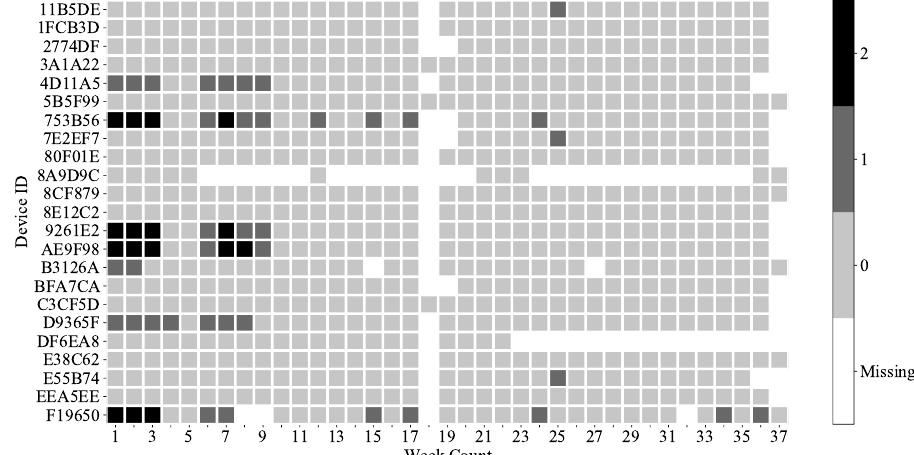
Figure 18. Raw data clustering result with week